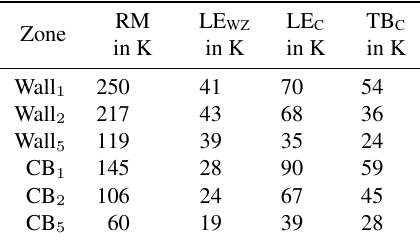
Table 2. Maximum average zone temperature difference for Raw Measurements ( RM ), Linear equation whole zones ( LE WZ ), Linear equation cluster ( LE C ), Tree bagger cluster ( TB C ) in